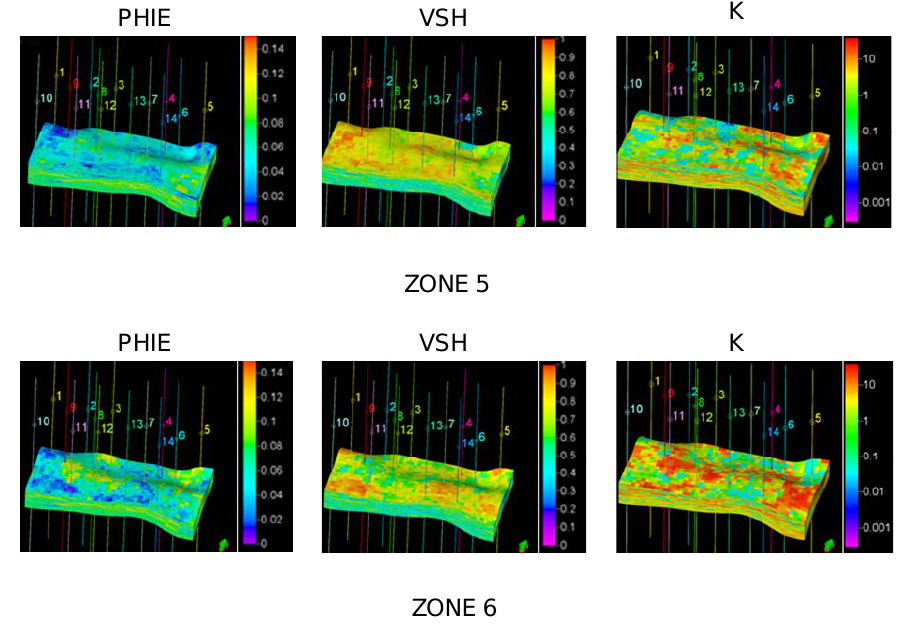
Fig. 9. Fractal distributions of effective porosity (PHIE), shale volume (VSH) and permeability (K) for zones 5 and 6.